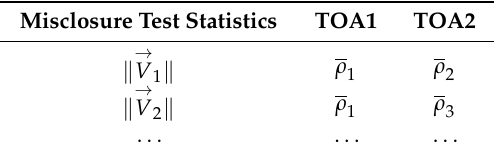
Table 1. Design of the misclosure table in the deceived NLOS data set.